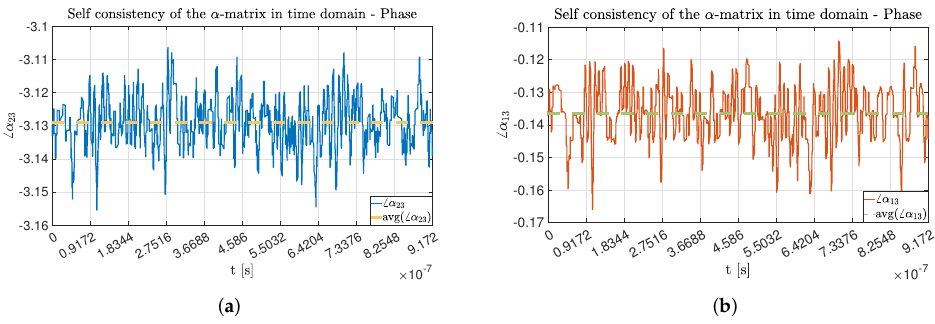
Figure 6. Phase values for the α -matrix coefficient during an experimental snapshot. In particular, in ( a ) phase values for the α 23 coefficient and in ( b ) phase values for the α 13 coefficient.